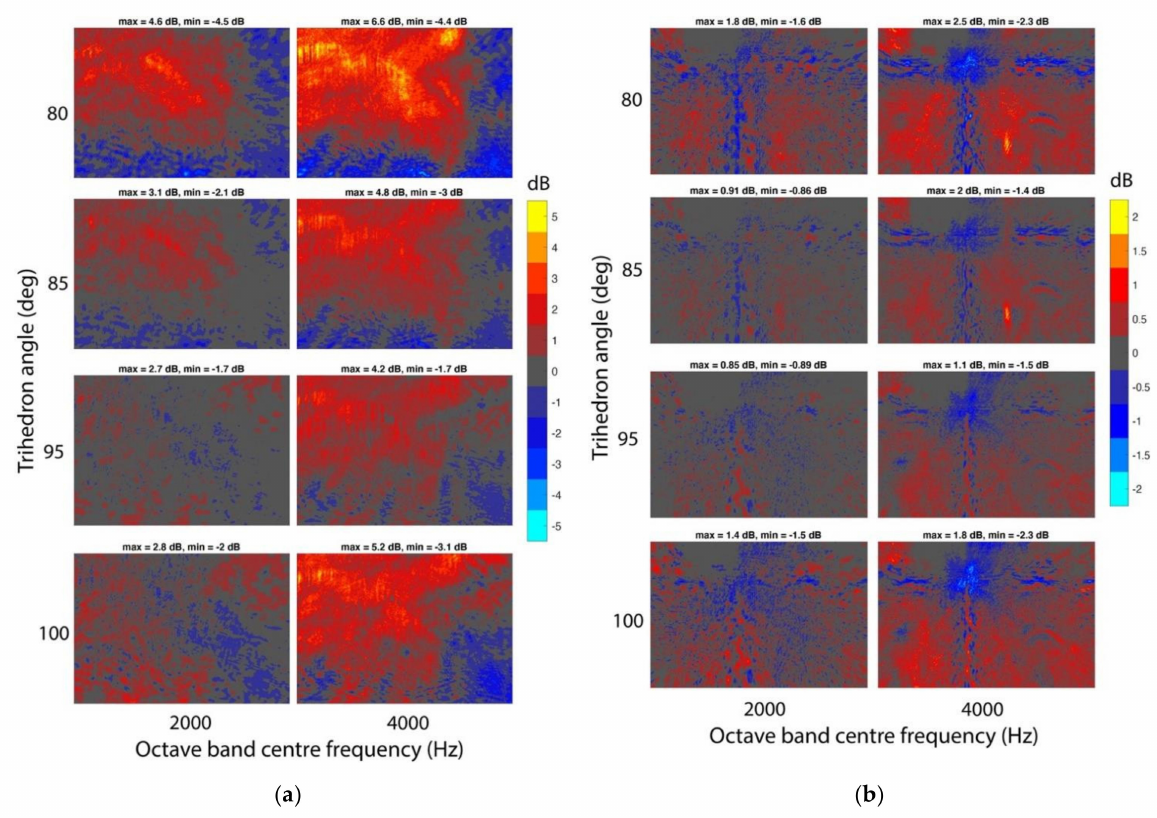
Figure 11. Change in reflected energy level over the horizontal receiver plane from trihedron angles other than 90 ◦ , with the source at Position 1: ( a ) Panna Meena ka Kund (partial model, without ground reflection); ( b ) Lahan Vav (full model). Subplots match the orientation of Figures 3 and 4 (for a and b,